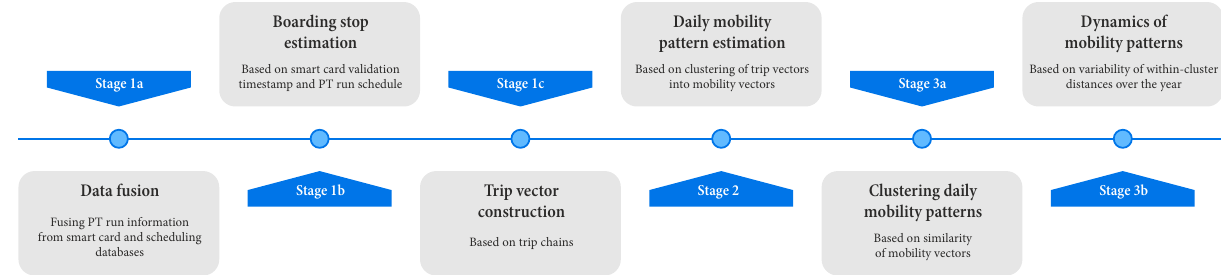
Figure 3. Illustration of minimum-cost bipartite matching results for mobility patterns of two dates